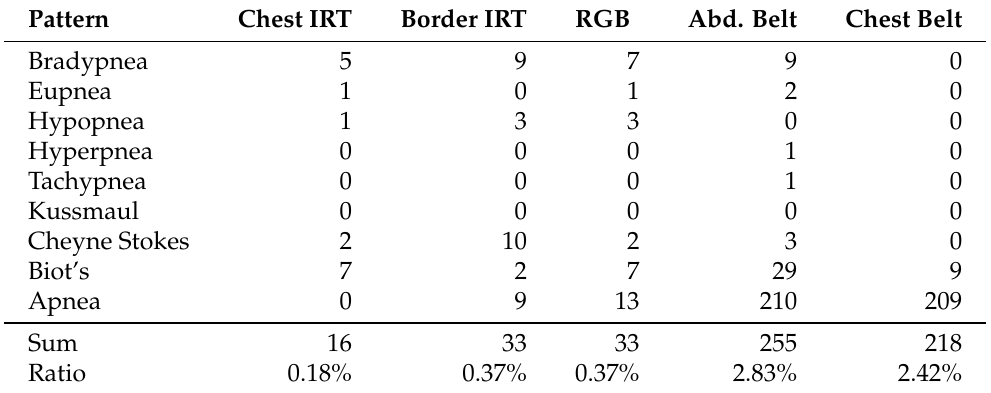
respiratory rate (RR) extraction of the different recorded breathing patterns and modalities.